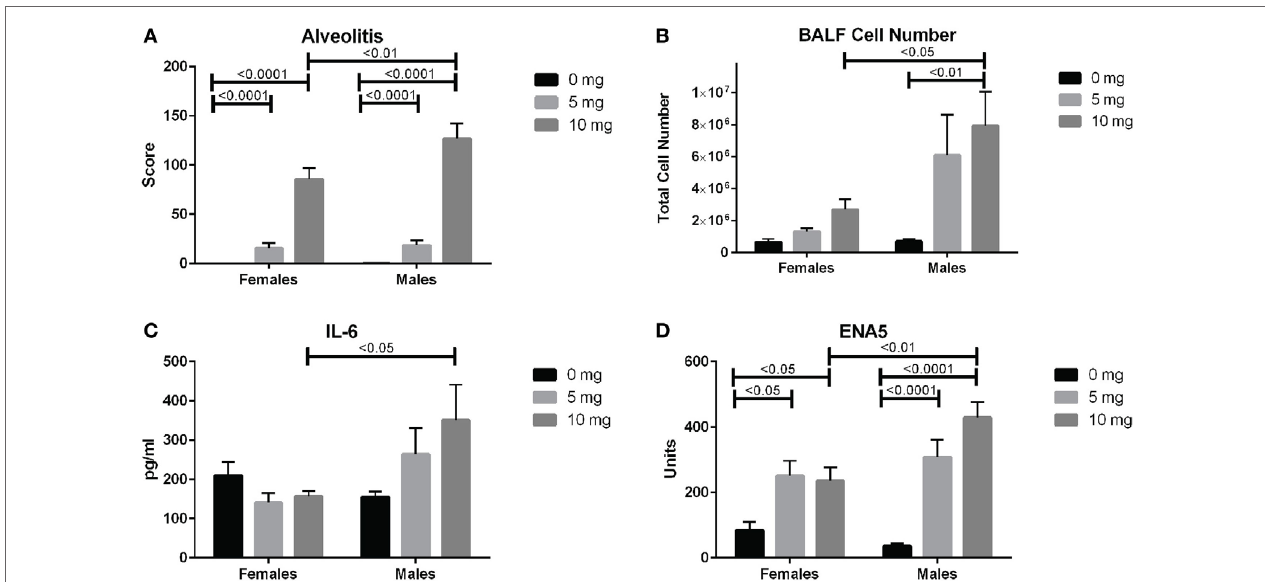
FigUre 6 | Sex differences in silica-exposed diversity outbred mice. Mice were exposed transorally to crystalline silica in PBS (see Figure 1 ) and females and males analyzed separately for sex effects by two-way ANOVA using Sidak’s multiple comparisons. Males exposed to 10 mg were found to have higher (a) alveolitis, (B) bronchoalveolar lavage fluid (BALF) cell number, (c) BALF IL-6, and (D) ENA5 autoantibodies compared to females at the same dose.